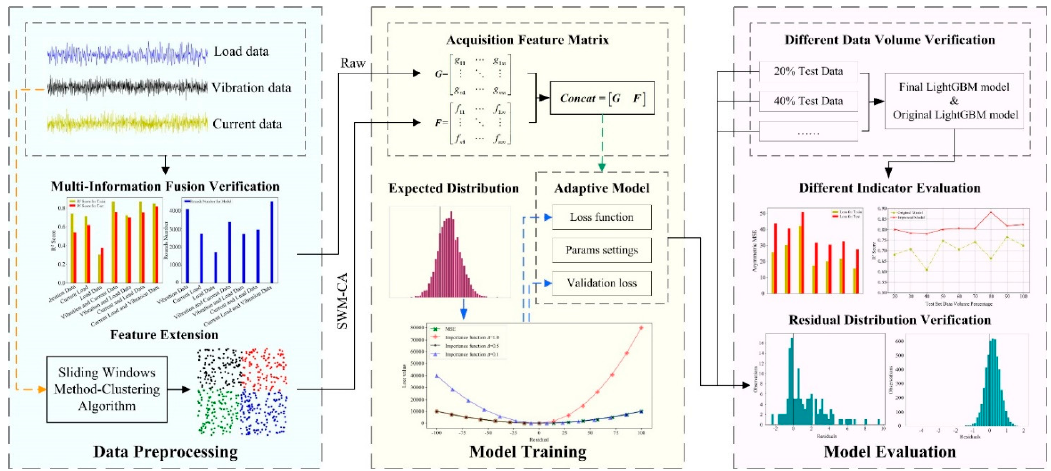
Figure 1. Architecture of remaining useful life (RUL) prediction method based on LightGBM.